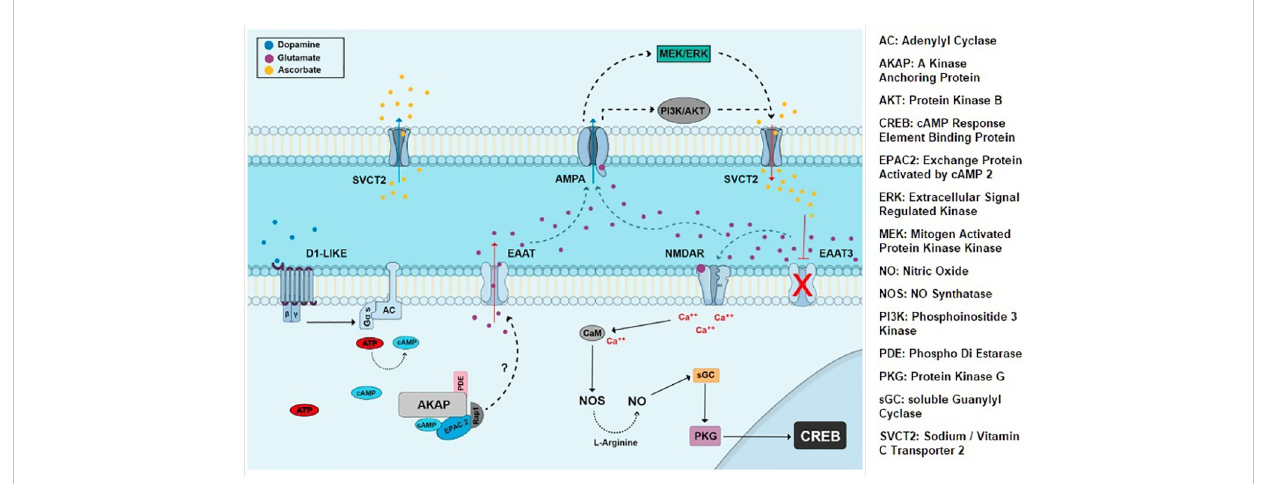
FIGURE 2 Extrinsic signaling involving dopamine, glutamate, EAATs and NMDA iGluRs. CREB is activated by NMDA and NO dependent cGMP/PKG pathway and affects neuronal proliferation and survival choices in chick retina